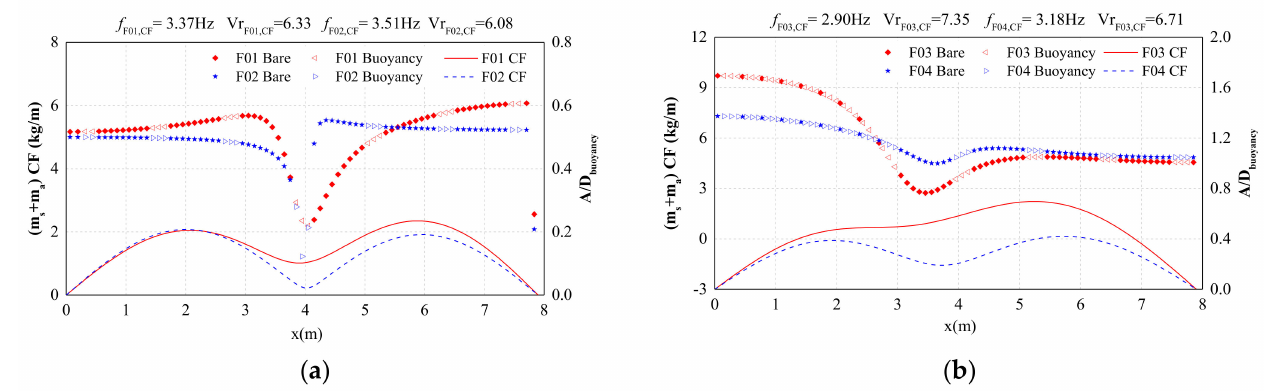
Figure 10. ( a ) F01 and F02. ( b ) F03 and F04. Total mass distribution of CF and IL sections along pipe length at 1.6 m/s flow rate for the four types of riser (m s is the structural mass per length of pipe model; m a is the added mass per length of pipe model; A/D bouyancy is the ratio of VIV displacement amplitude to outer diameter of buoyancy module; f F01,CF , f F02,CF , f F03,CF and f F04,CF are the dominant VIV frequency of F01, F02, F03 and F04 in CF direction; Vr F01,CF, Vr F02,CF , Vr F03,CF and Vr F04,CF are the reduced velocity referring to f F01,CF , f F02,CF , f F03,CF and f F04,CF